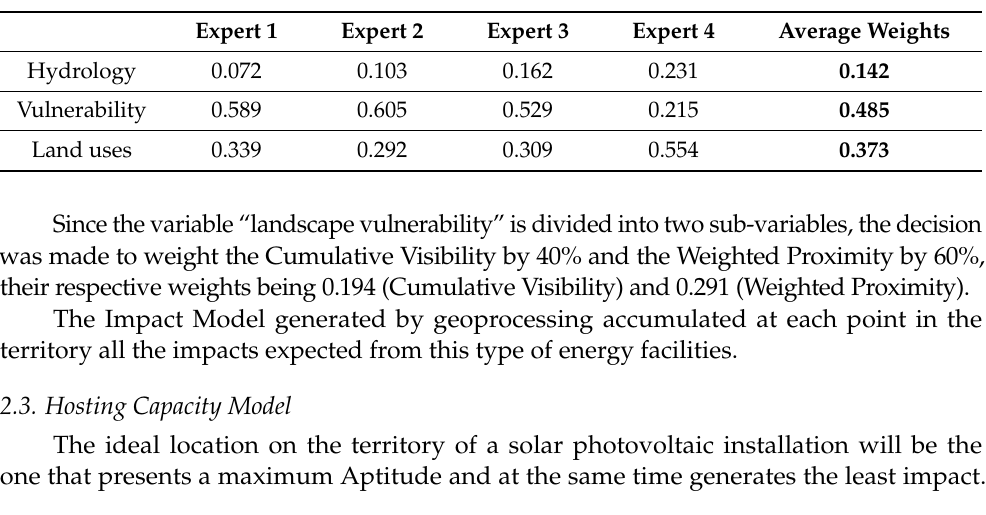
Table 2. Average weights of the impact